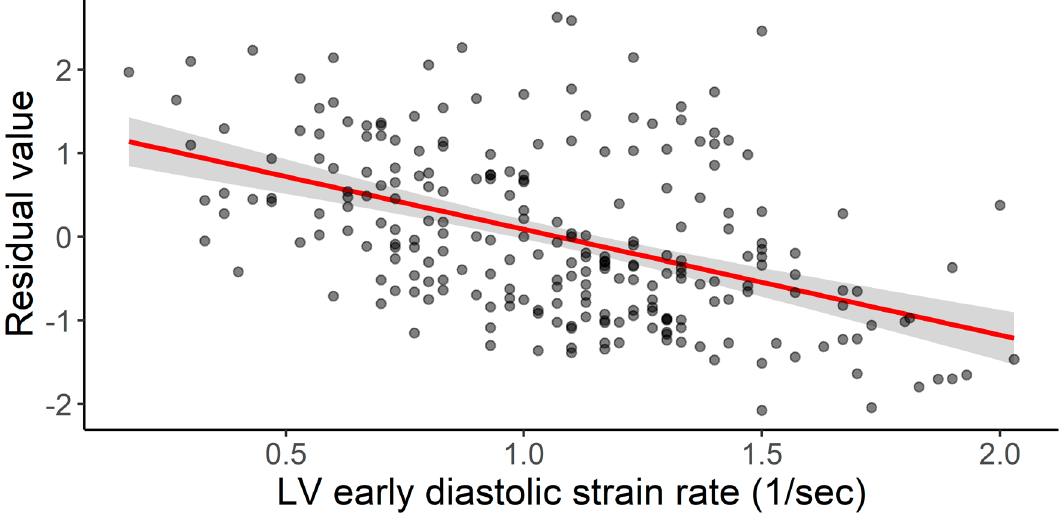
Figure 3. Association of higher early diastolic strain rate with disproportionate LA myopathy. Shown is the relationship between early diastolic strain rate and the residual values of the regression model between LV GLS and LA reservoir strain (lower residual values indicate disproportionate LA myopathy). The red line represents the linear regression model between the 2 variables. Higher early diastolic strain rate (i.e. better diastolic function) was associated with disproportionate LA myopathy (β coefficient: − 1.26, SE: 0.15, P <